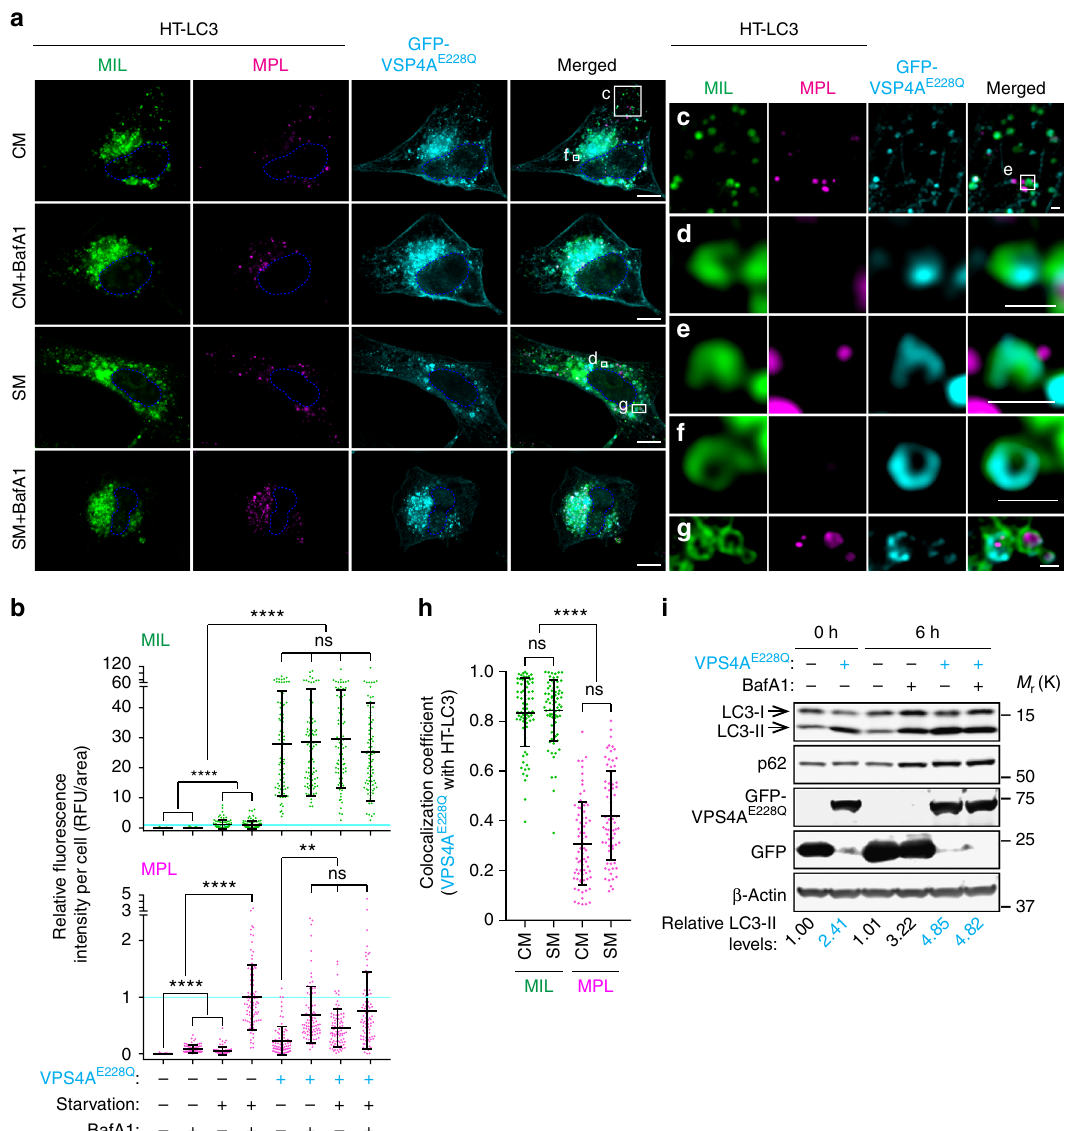
Fig. 6 Inhibition of VPS4 accumulates MIL + MPL − phagophores and impairs autophagic fl ux. HT-LC3 U-2 OS ( a – h ) and wild-type U2-OS cells ( i ) were transfected with GFP-VPS4A E228Q or control GFP. a Twelve hours after the transfection, cells were incubated in CM or SM for 3 h and subjected to the HT-LC3 autophagosome completion assay followed by confocal microscopy. The scale bars represent 10 μ m and 1 μ m in the magni fi ed images. b The cytoplasmic fl uorescence intensities of MIL and MPL per cell in ( a ) were quanti fi ed and normalized to the respective mean fl uorescence intensities of control GFP transfected cells starved in the presence of BafA1 ( n > 81). Data shown are representative of two independent experiments. ( c – g ) Magni fi ed images in the boxed areas in ( a ) are shown. h Colocalization coef fi cient of GFP-VPS4A E228Q with MIL or MPL-labeled HT-LC3 per cell in ( a ) were quanti fi ed and shown ( n > 72). In ( b and h ), statistical signi fi cance was determined by Kruskal – Wallis one-way ANOVA on ranks followed by Dunn ’ s multiple comparison test. All values are mean ± SD. ns not signi fi cant; ** p ≤ 0.01; **** p ≤ 0.0001. i Six hours after transfection (0 h time point), cells were incubated in the presence or absence of 100 nM BafA for 6 h and subjected to immunoblotting using the indicated antibodies. The LC3-II levels relative to respective β -actin were quanti fi ed and normalized to the value of control GFP cells at time